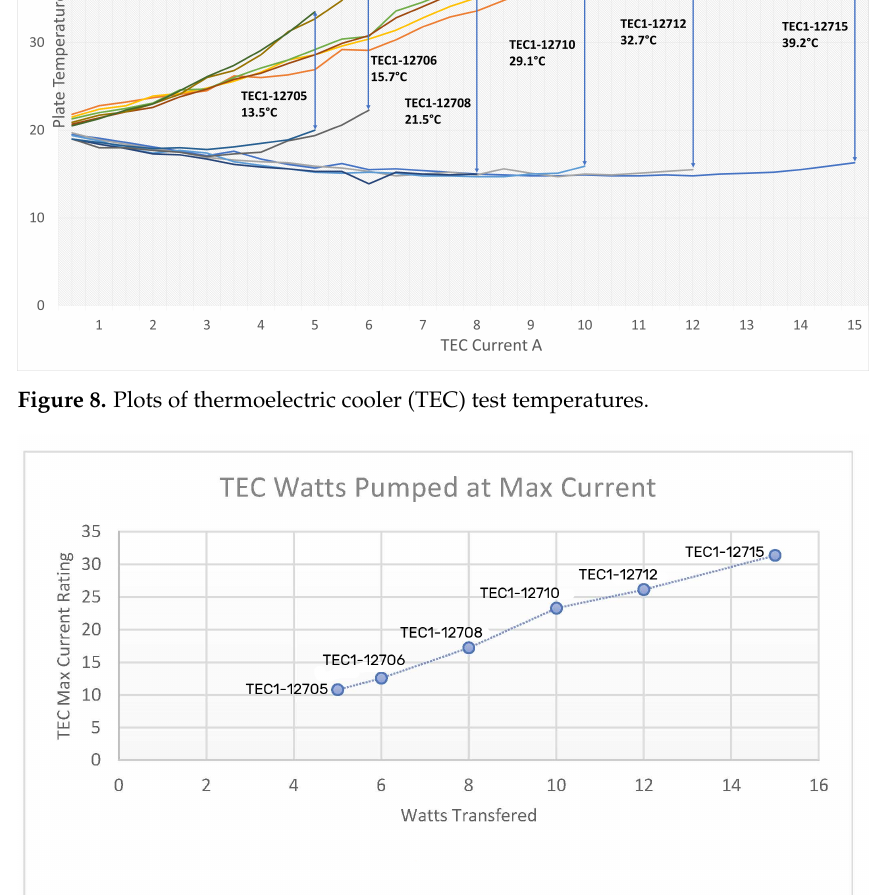
Figure 9. Watts pumped per 16 cm 2 (TEC area) at maximum current at room